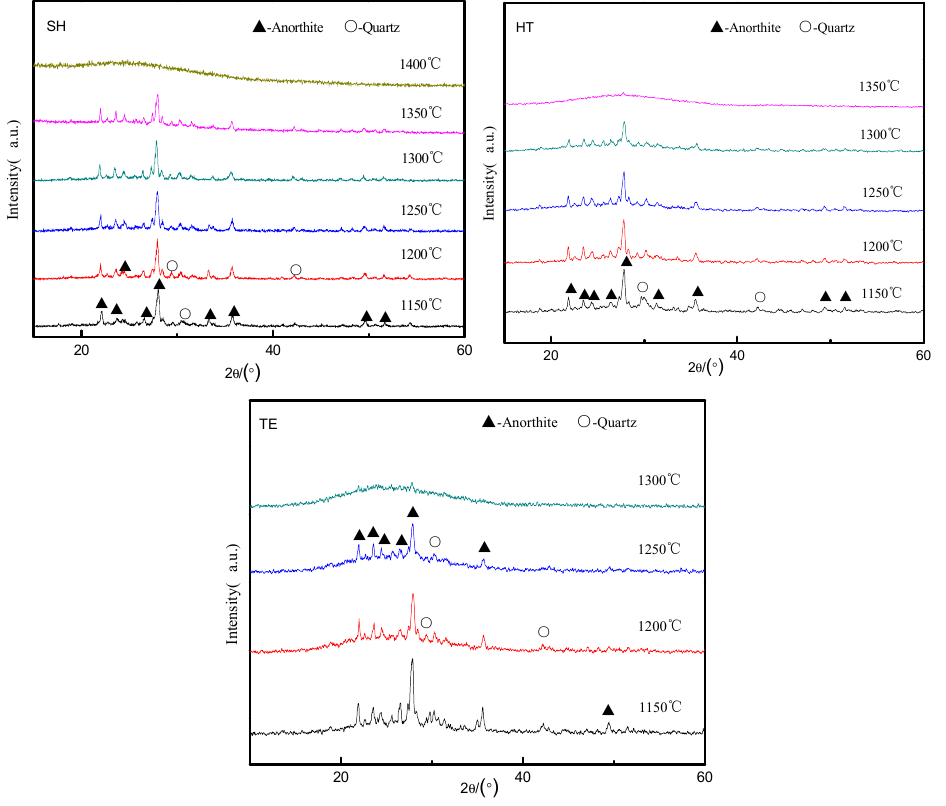
Figure 4. The phase composition of the slags at high temperatures.